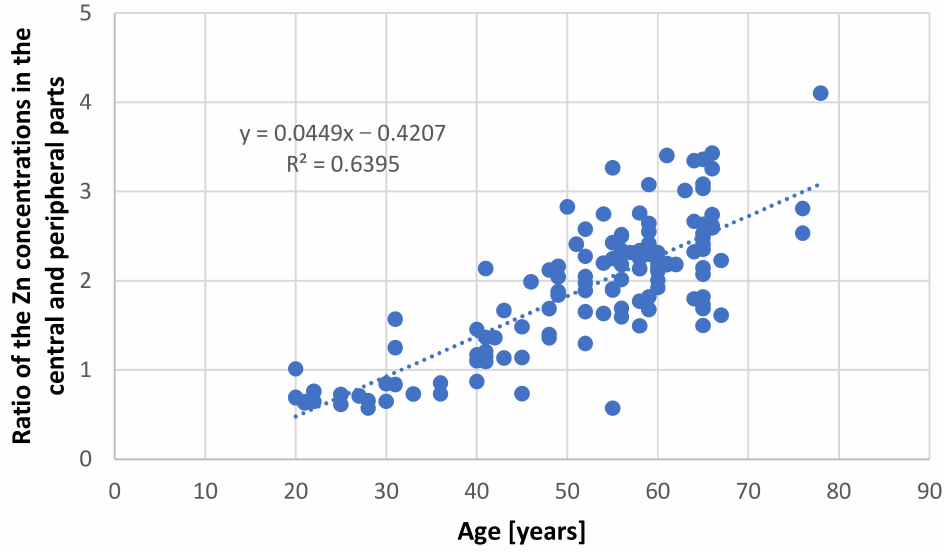
Figure 1. Relationship between ratio of zinc concentration in the central and peripheral parts of the prostate and age in samples taken from persons without proliferative